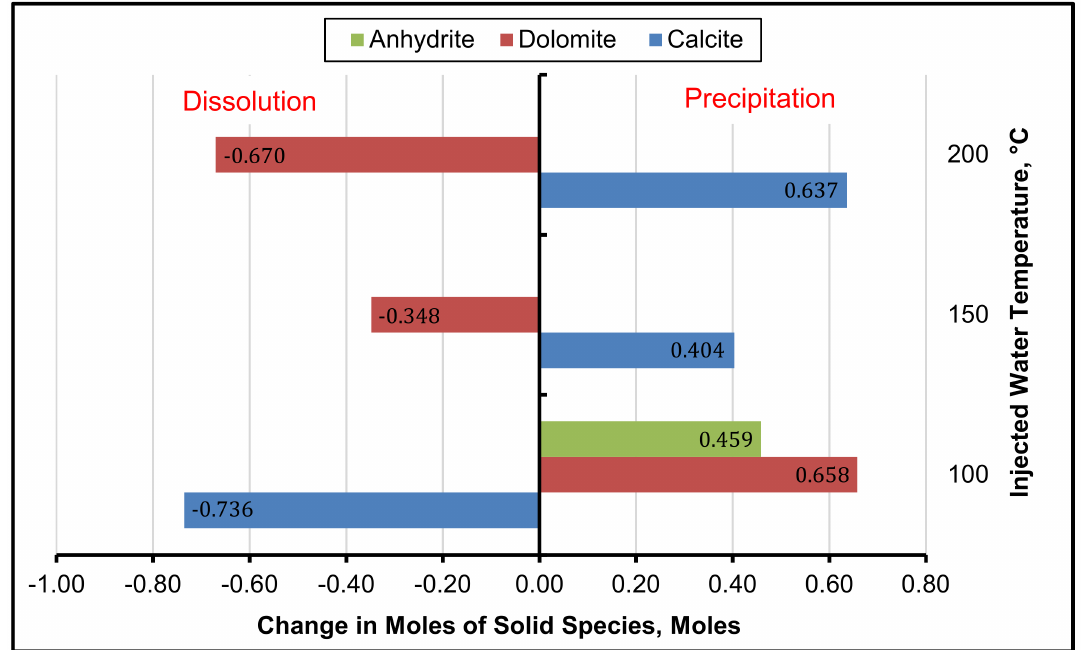
Figure 7. Effect of injected water temperature on solid species for the first gridblock at 6 PVs with fixed reservoir temperature of 200 ◦